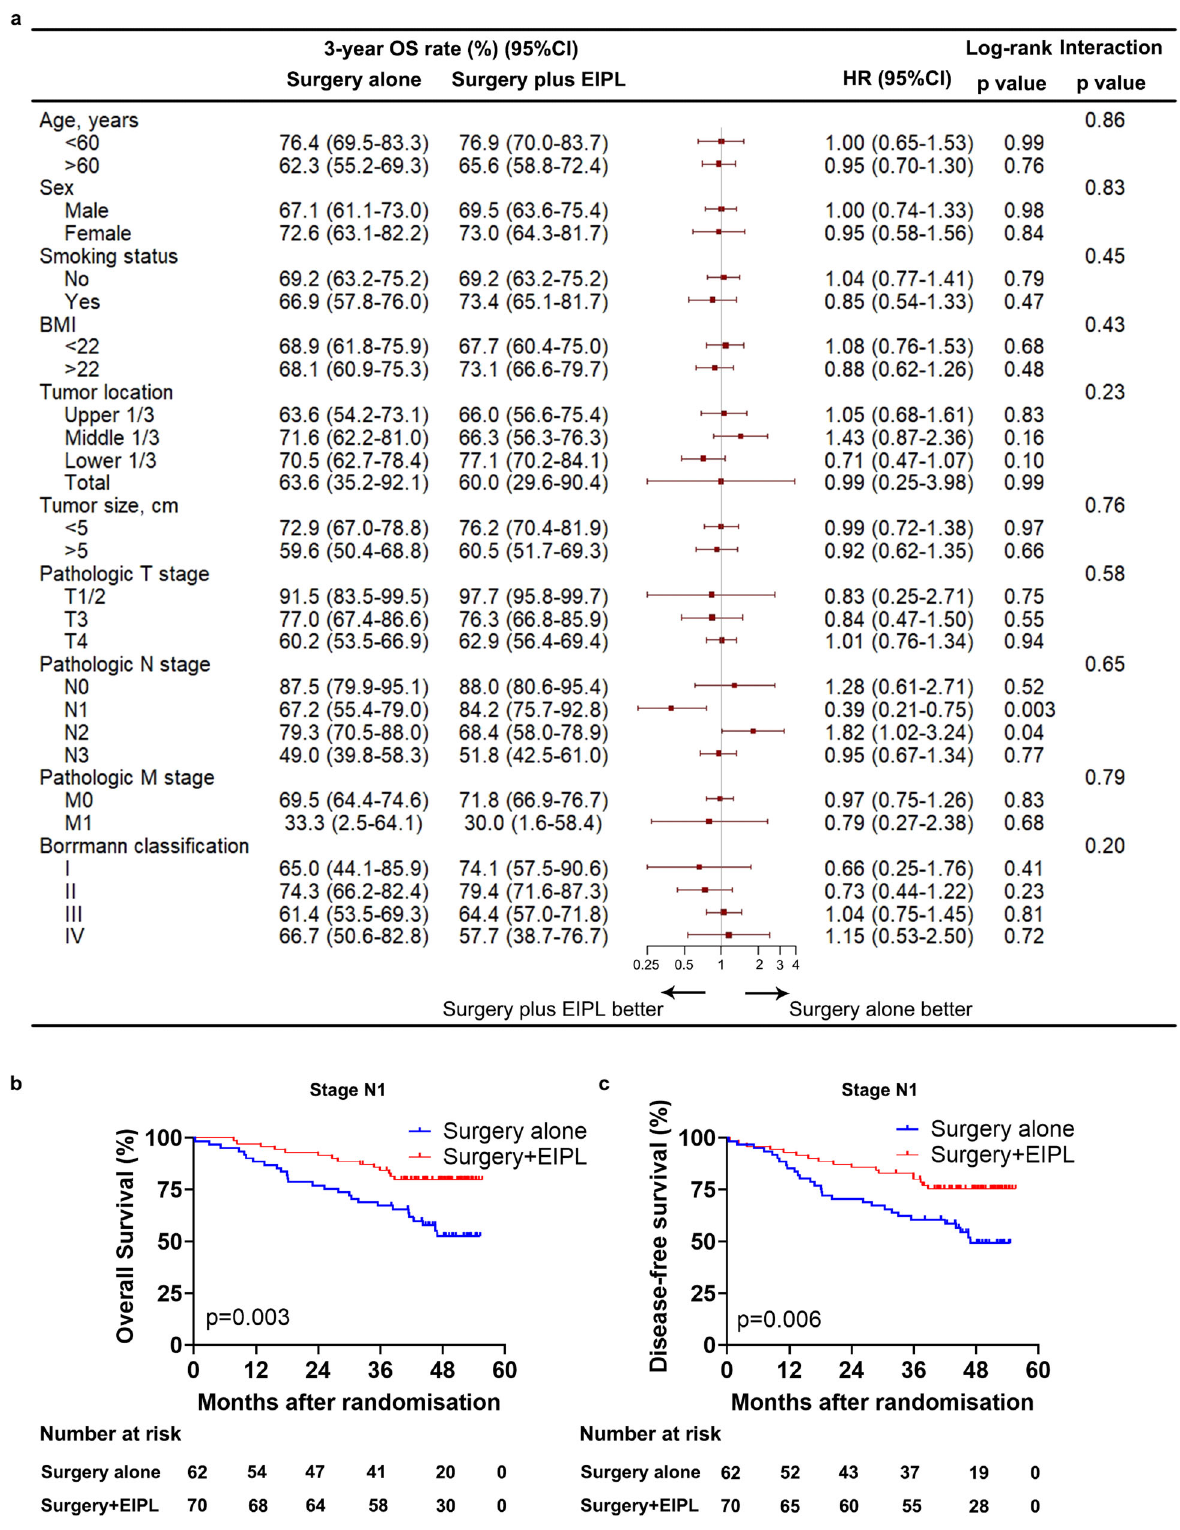
Fig. 3 Subgroup analyses. a Subgroup analyses of overall survival according to the clinicopathological characteristics of the patients ( n = 662). Data are plotted as HR value (red squares) with the corresponding two-sided 95% CI (error bars) based on the Cox regression method. b , c Kaplan – Meier estimates of overall survival ( b ) and disease-free survival ( c ) in stage N1 patients by treatment group. Log-rank test was used to compare both curves. EIPL extensive intraoperative peritoneal lavage, OS overall survival, HR hazard ratio, 95% CI 95% con fi dence interval, BMI body mass index.